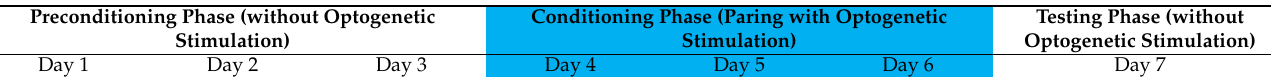
Table 1. Timeline of CPP